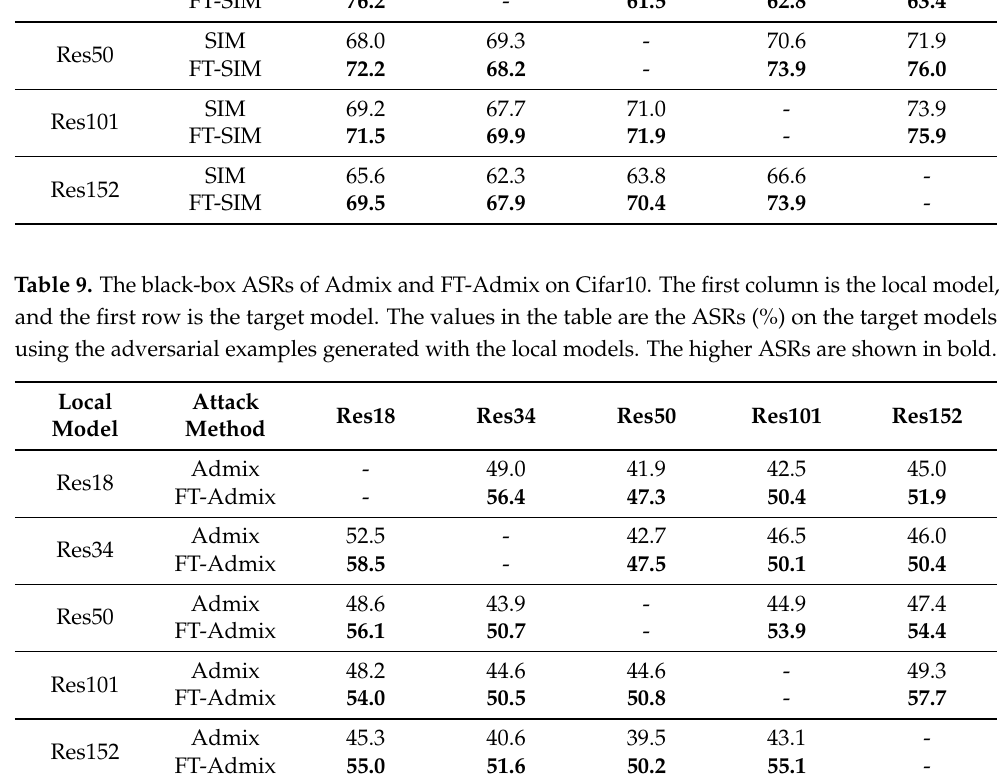
Table 8. The black-box ASRs of SIM and FT-SIM on Cifar10. The first column is the local model, and the first row is the target model. The values in the table are the ASRs (%) on the target models using the adversarial examples generated with the local models. The higher ASRs are shown in bold.